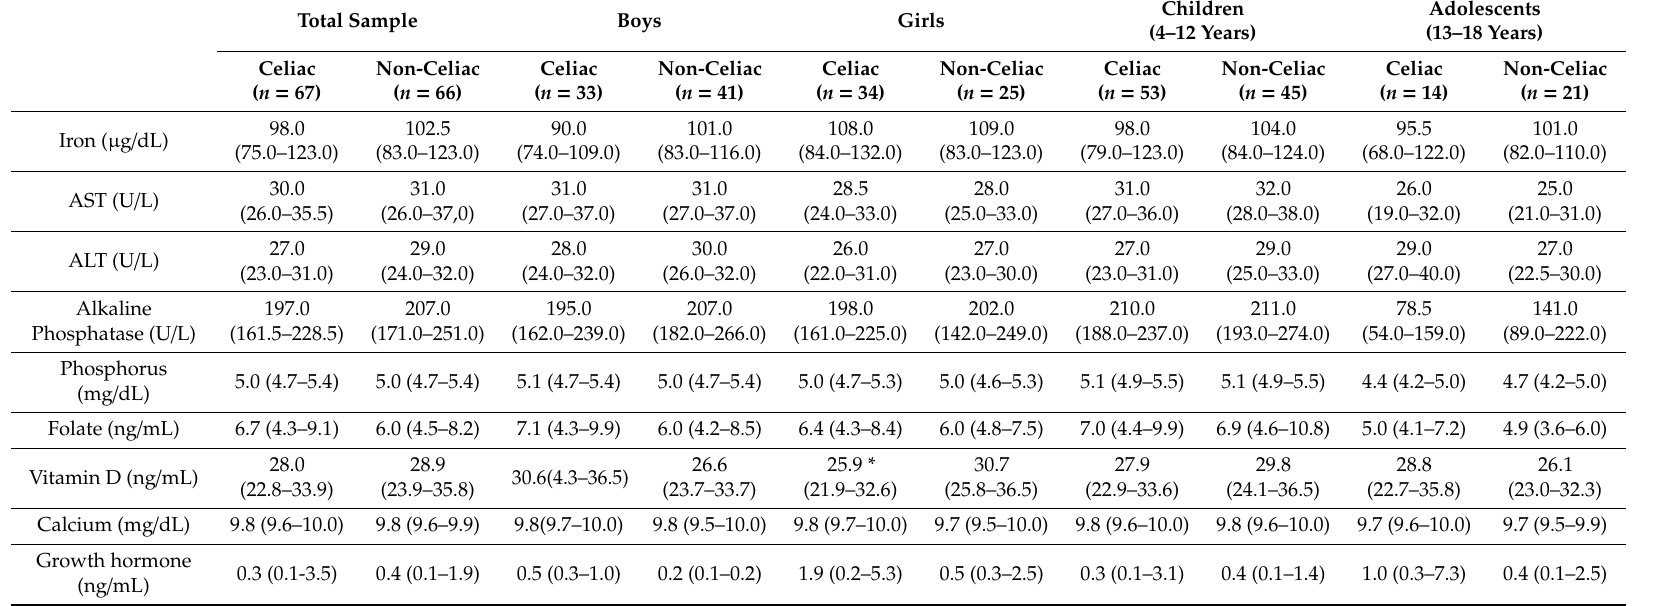
Table 10. Biochemical parameters in celiac and non-celiac children and